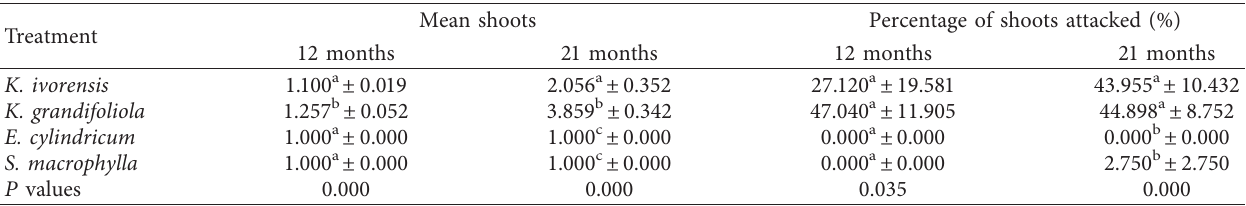
Figure 3: Mean number of shoots on the attacked and nonattacked saplings of the four Meliaceae species 12 and 21 months after planting in the moist semideciduous forest. Table 2: Mean shoots and percentage shoots attacked for K. grandifoliola, S. macrophylla, K. ivorensis, and E. cylindricum in the species trial 12 and 21 months after planting in the moist semideciduous